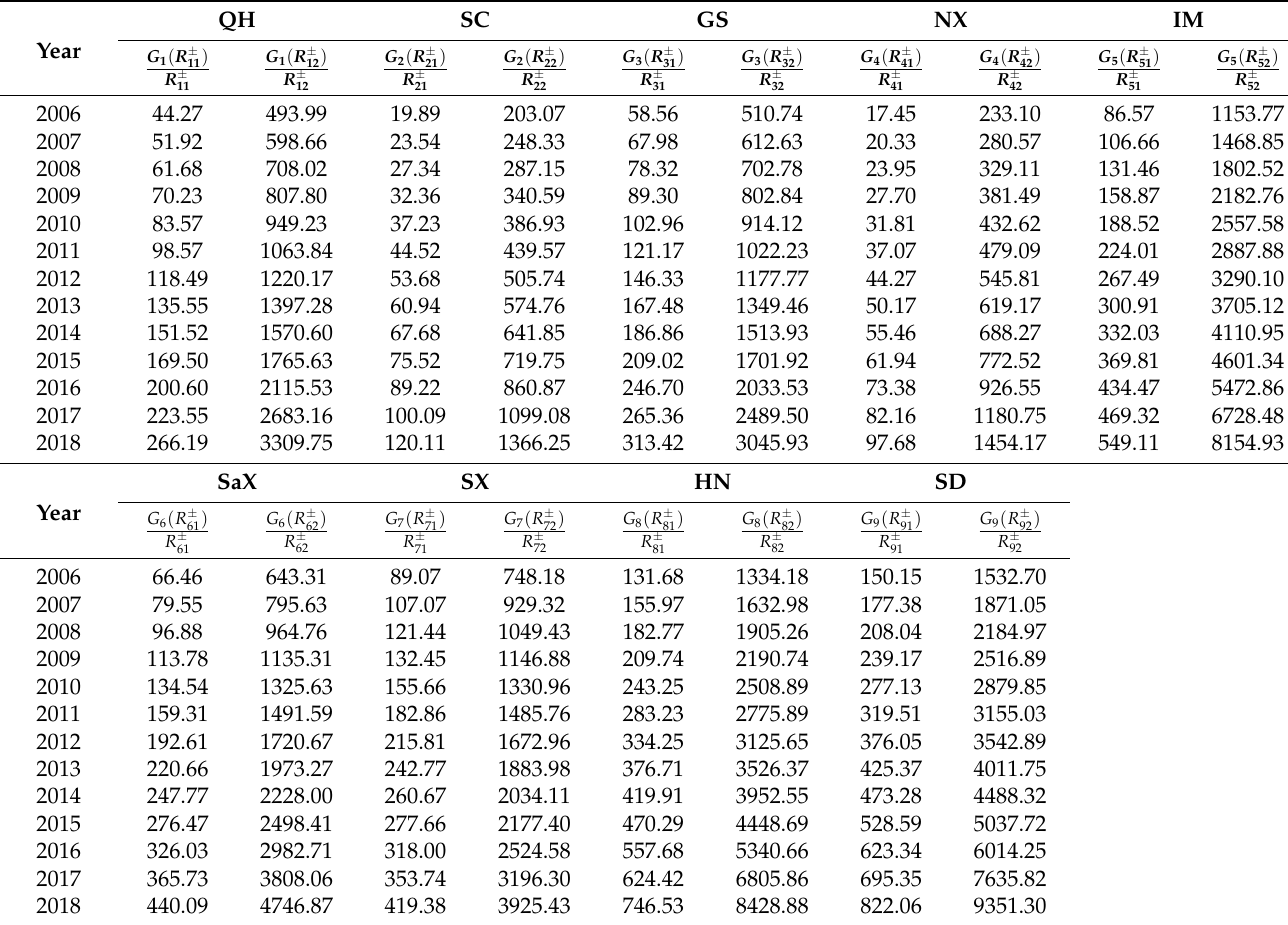
Table A2. Ratio of GDP to water pollutants emission amount for subareas in the Yellow River Basin. (Unit: 10,000